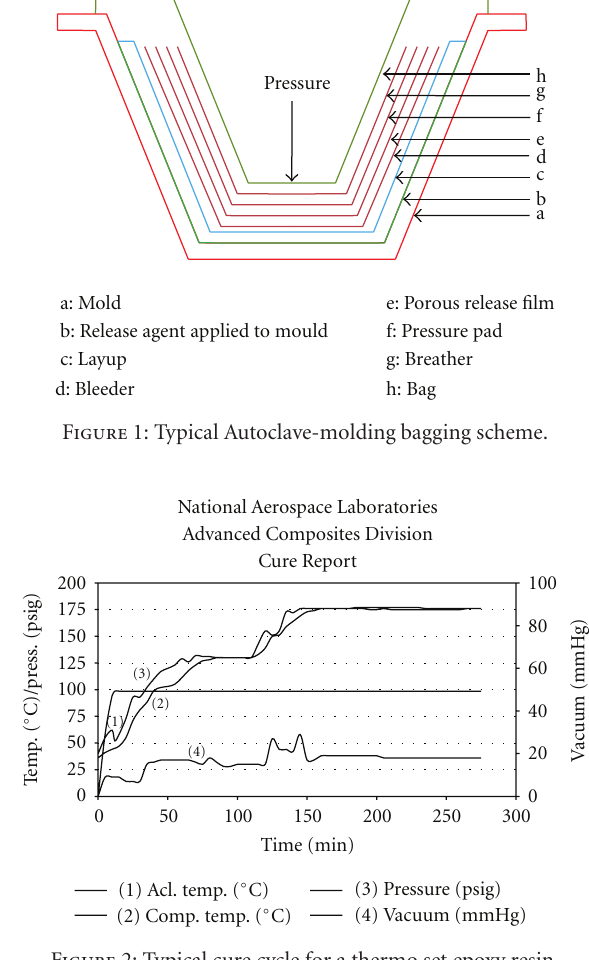
Figure 2: Typical cure cycle for a thermo set epoxy